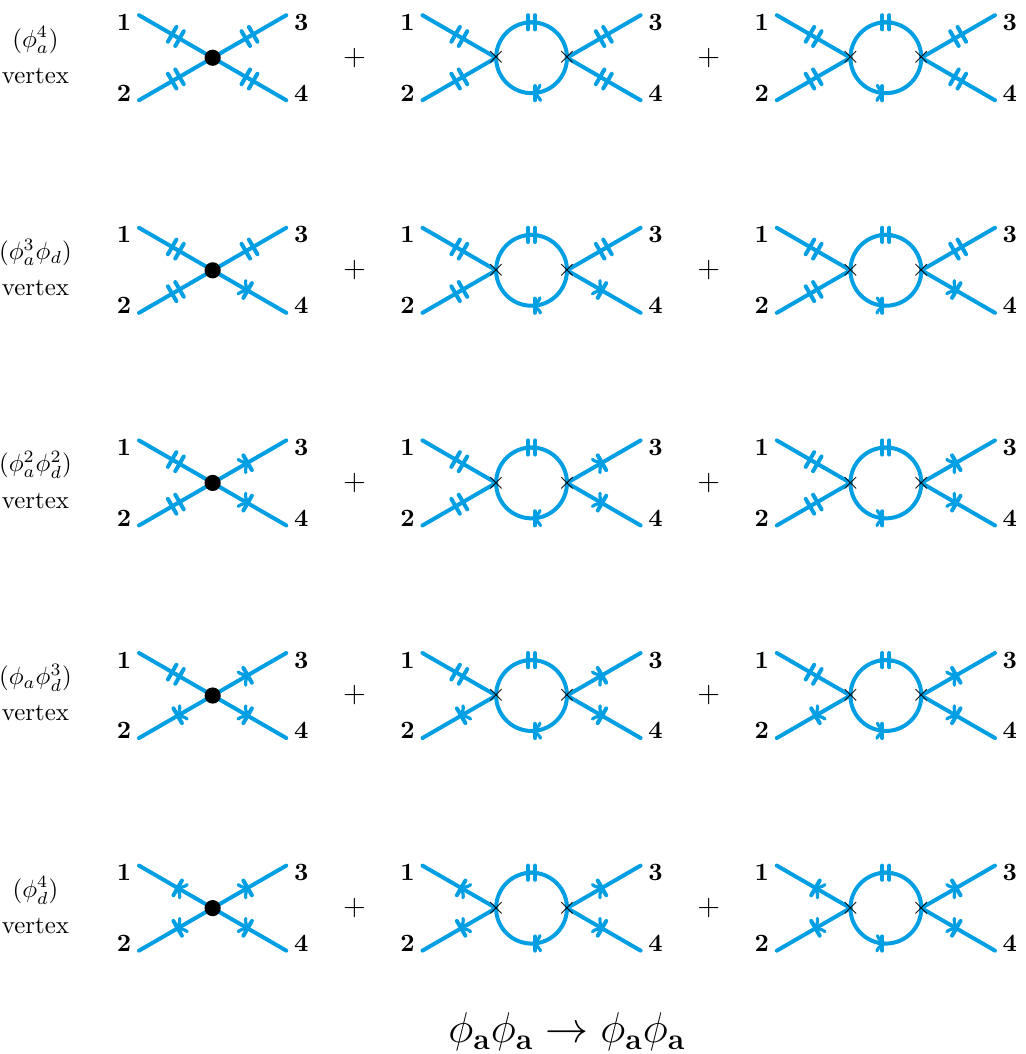
Figure 36. Renormalization of the quartic couplings in the average-di(cid:11)erence